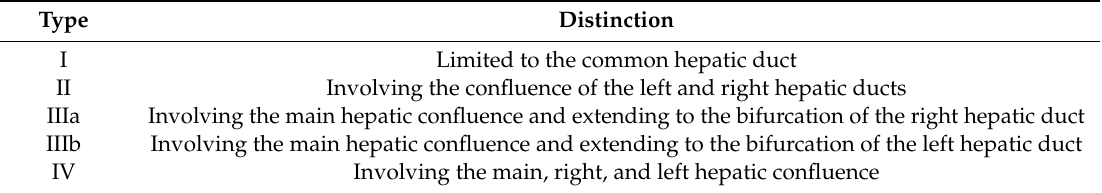
Table 3. Bismuth–Corlette classification